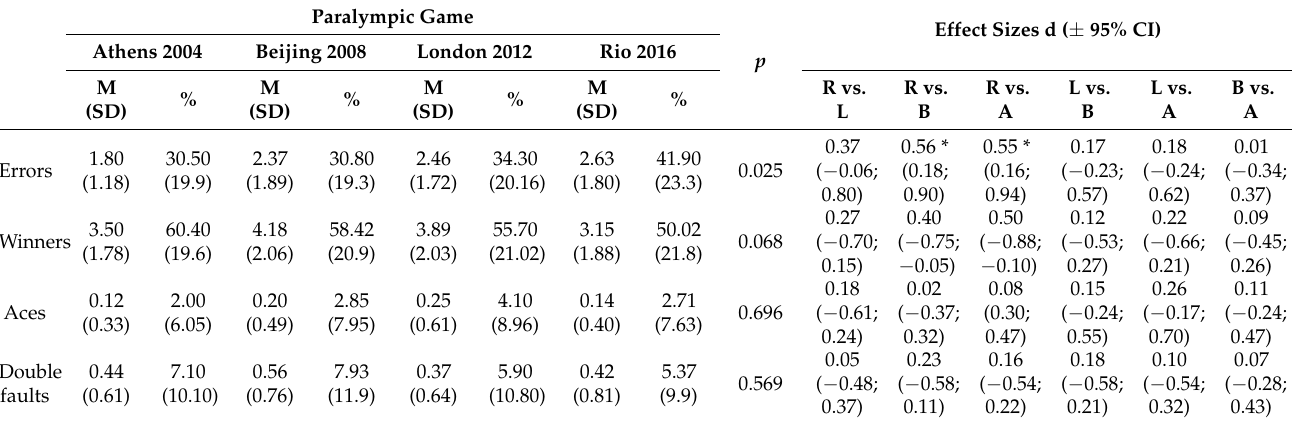
Table 2. Differences of effectivity of the last shot comparing Paralympic Games.